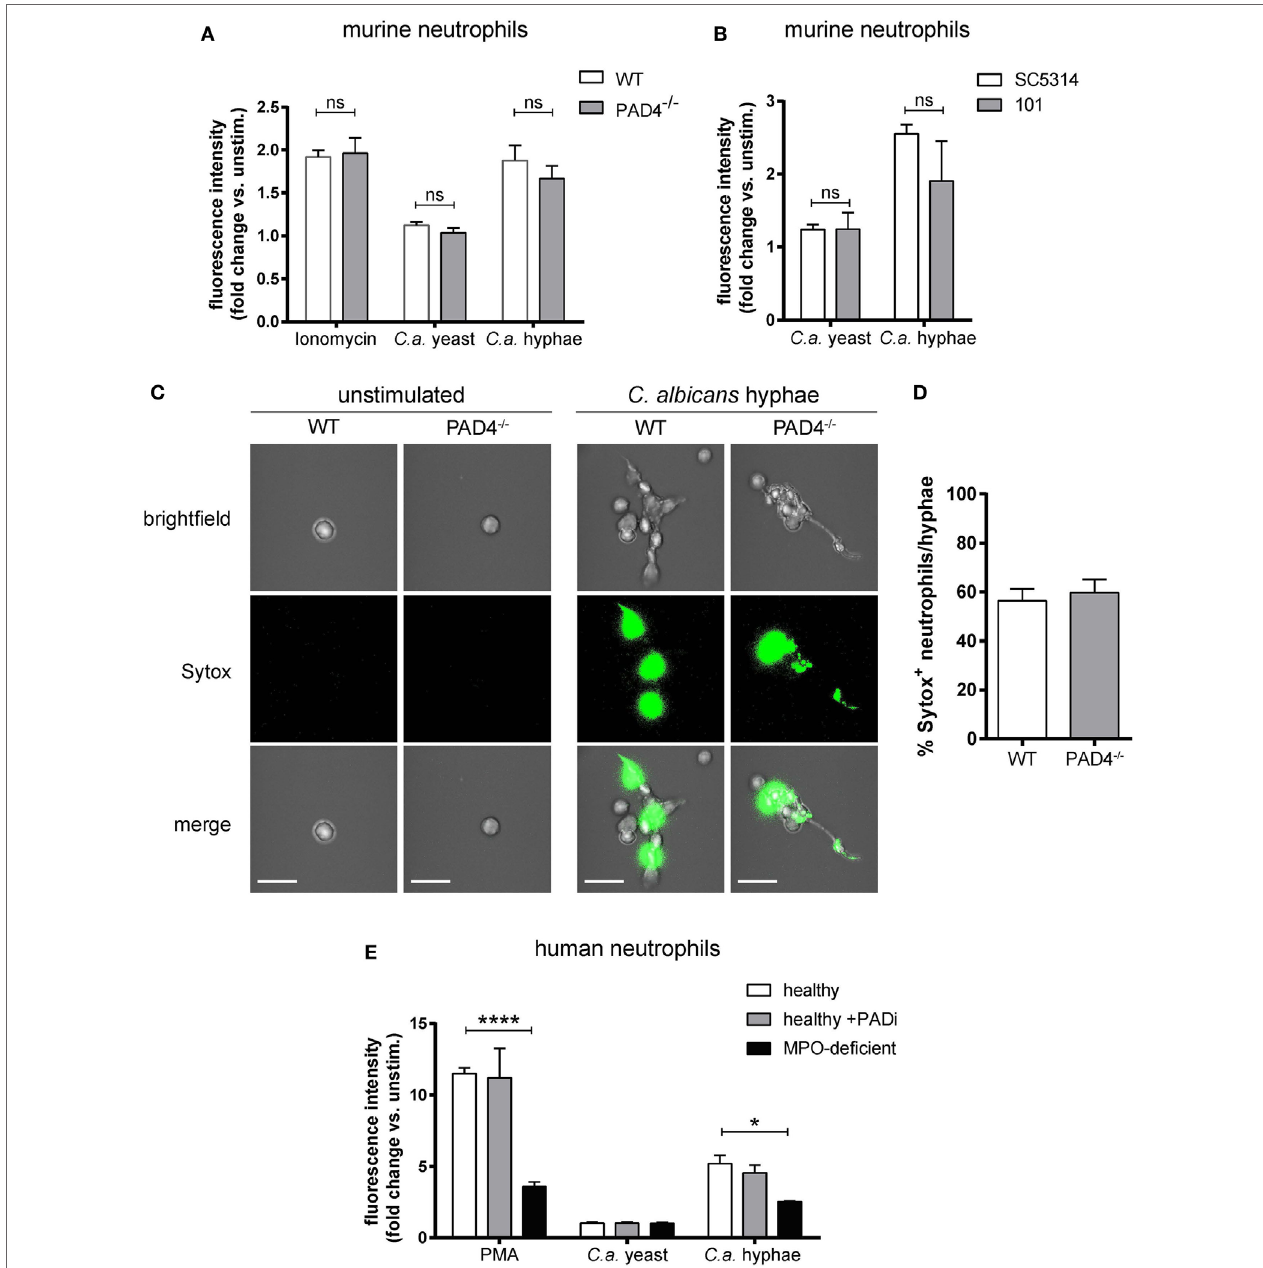
FigUre 2 | NETosis in response to Candida albicans hyphae is independent of Peptidylarginine deiminase 4 (PAD4). (a) The release of extracellular DNA from murine bone marrow neutrophils was detected by Sytox green after stimulation for 2.5 h with the yeast-locked strain Δ hgc1 ( C.a. yeast), preformed hyphae of the control strain Δ hgc1 + HGC1 ( C.a. hyphae), or ionomycin as indicated. The increase in fluorescence intensity from stimulated relative to unstimulated neutrophils is shown. Each bar represents the mean with standard error of the mean (SEM) of each group ( n = 3) with data pooled from three independent experiments. (B) Bone marrow neutrophils were stimulated with C. albicans yeast cells or preformed hyphae of the highly virulent lab strain SC5413 and the low-virulent strain 101 as indicated. The release of extracellular DNA was detected by Sytox green as in (a) . Data are the mean with SEM of each group ( n = 3) with data pooled from three independent experiments. (c,D) The release of DNA from WT and PAD4 − / − neutrophils that were stimulated and stained with Sytox as described in (a) was visualized by immunofluorescence microscopy. Representative images for each condition are shown in (c) . Scale bar = 20 µm. The frequency of Sytox + neutrophils among all C. albicans hyphae-associated neutrophils is shown in (D) . The bars are the mean with SEM of 15 images analyzed per condition. (e) Human peripheral blood neutrophils from healthy donors that were treated with the PAD inhibitor Cl-amidine or left untreated and from patients with acquired myeloperoxidase-deficiency were stimulated for 2.5 h with the yeast-locked strain Δ hgc1 ( C.a. yeast), preformed hyphae of the control strain Δ hgc1 + HGC1 ( C.a. hyphae), or phorbol 12-myristate 13-acetate. Sytox was detected as described in (a) . Each bar represents the mean with SEM of three technical replicates of each group. Data are representative of one out of two independent